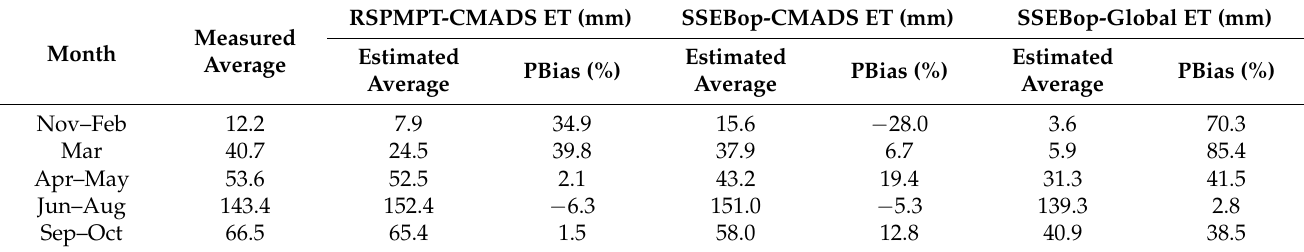
Table 2. Averaged measured and estimated ET in different crop growth stages from 2013 to 2016. RSPMPT-CMADS ET Measured Month Average